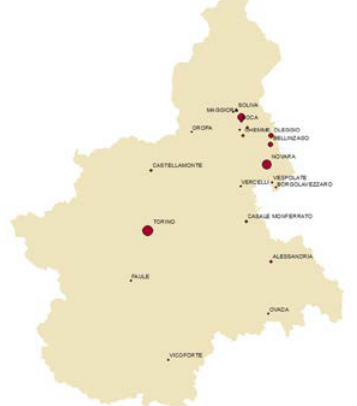
Figure 3. Antonelli’s design selected by “Town”; a proportional symbology describe the number of design realized for each